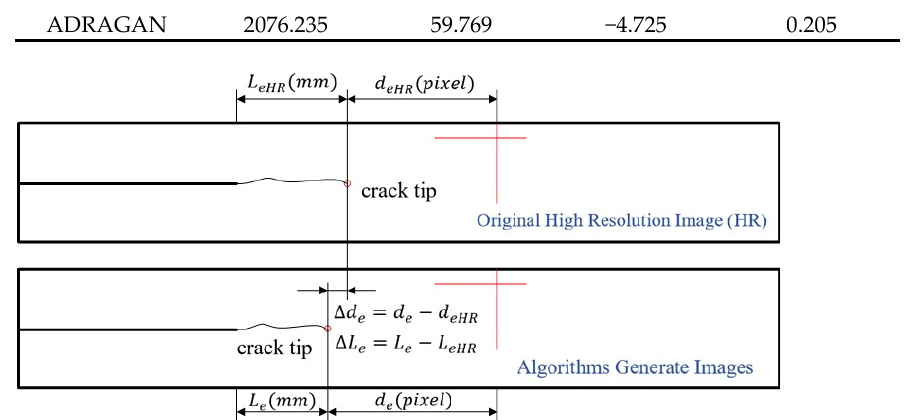
Figure 7. Contrast in size between images generated by the algorithms and the original high-resolution image.